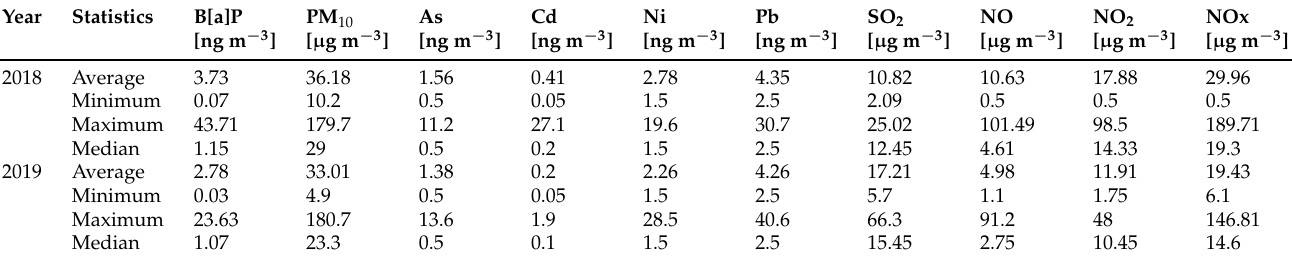
Table 6. Descriptive